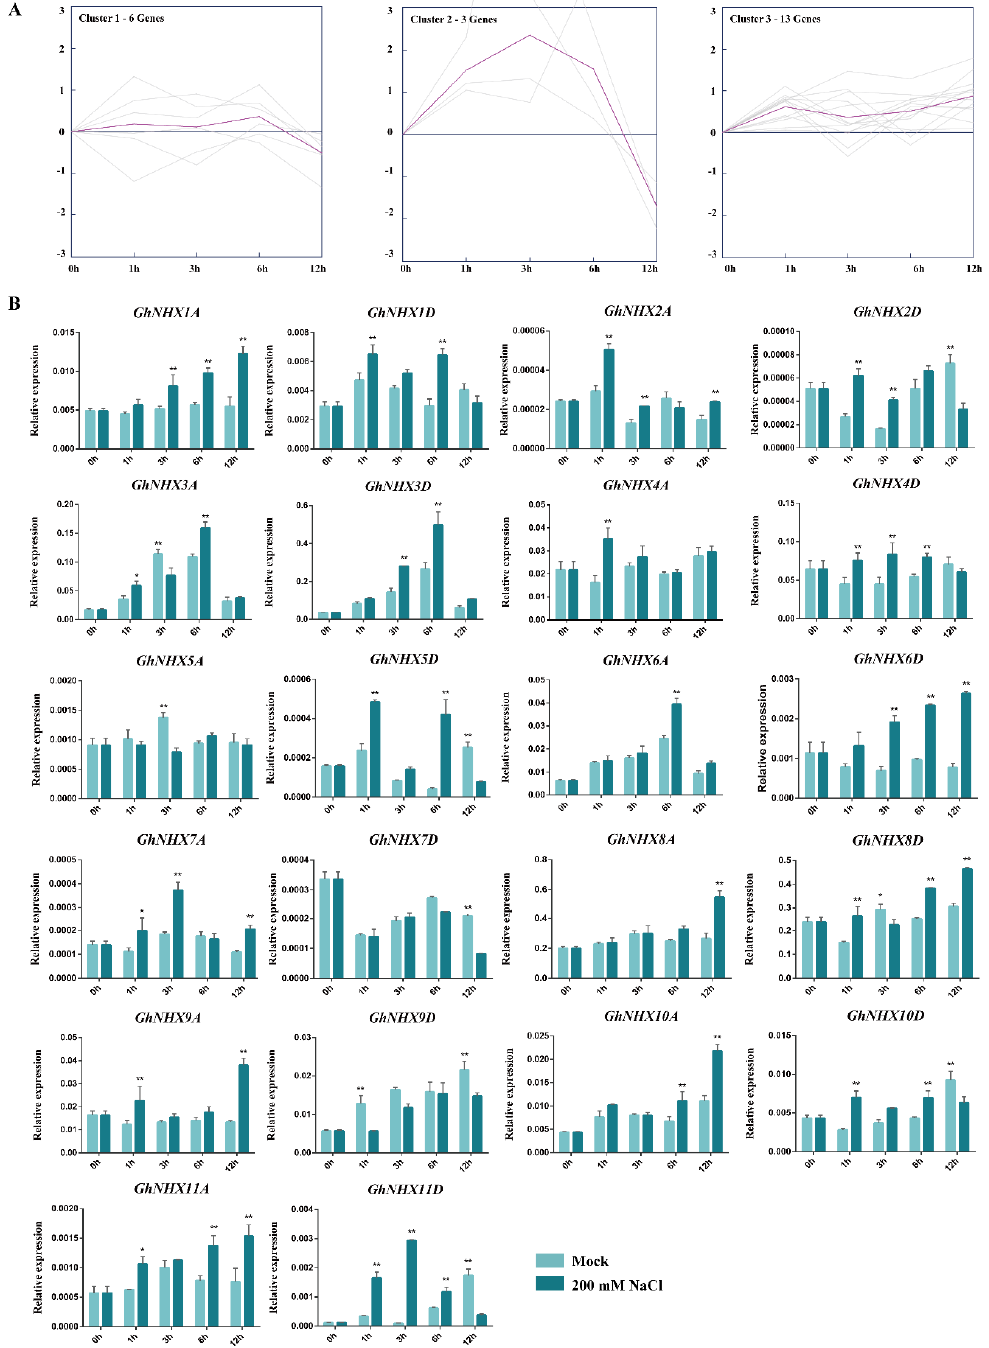
Figure 4. Expression patterns of GhNHX genes in leaves after the 200 mM NaCl treatment. ( A ) Cluster analysis of expression profiles of GhNHX genes under the NaCl treatment. The cluster analysis was developed using the K-means method on the expression profiles of G. hirsutum NHX genes under the NaCl treatment. The expression pattern of each gene is indicated by a gray line, and the representative expression pattern of each cluster is represented by a purple line. The x-axis presents the examined time-points after the salt treatment, whereas the y-axis presents the scale of the relative expression levels. ( B ) Expression profiles of GhNHX genes under the NaCl treatment. The x-axis presents the examined time-points after the salt treatment, whereas the y-axis presents the relative expression levels. Error bars indicate the standard deviation of three biological replicates (* p < 0.05, ** p < 0.01; t